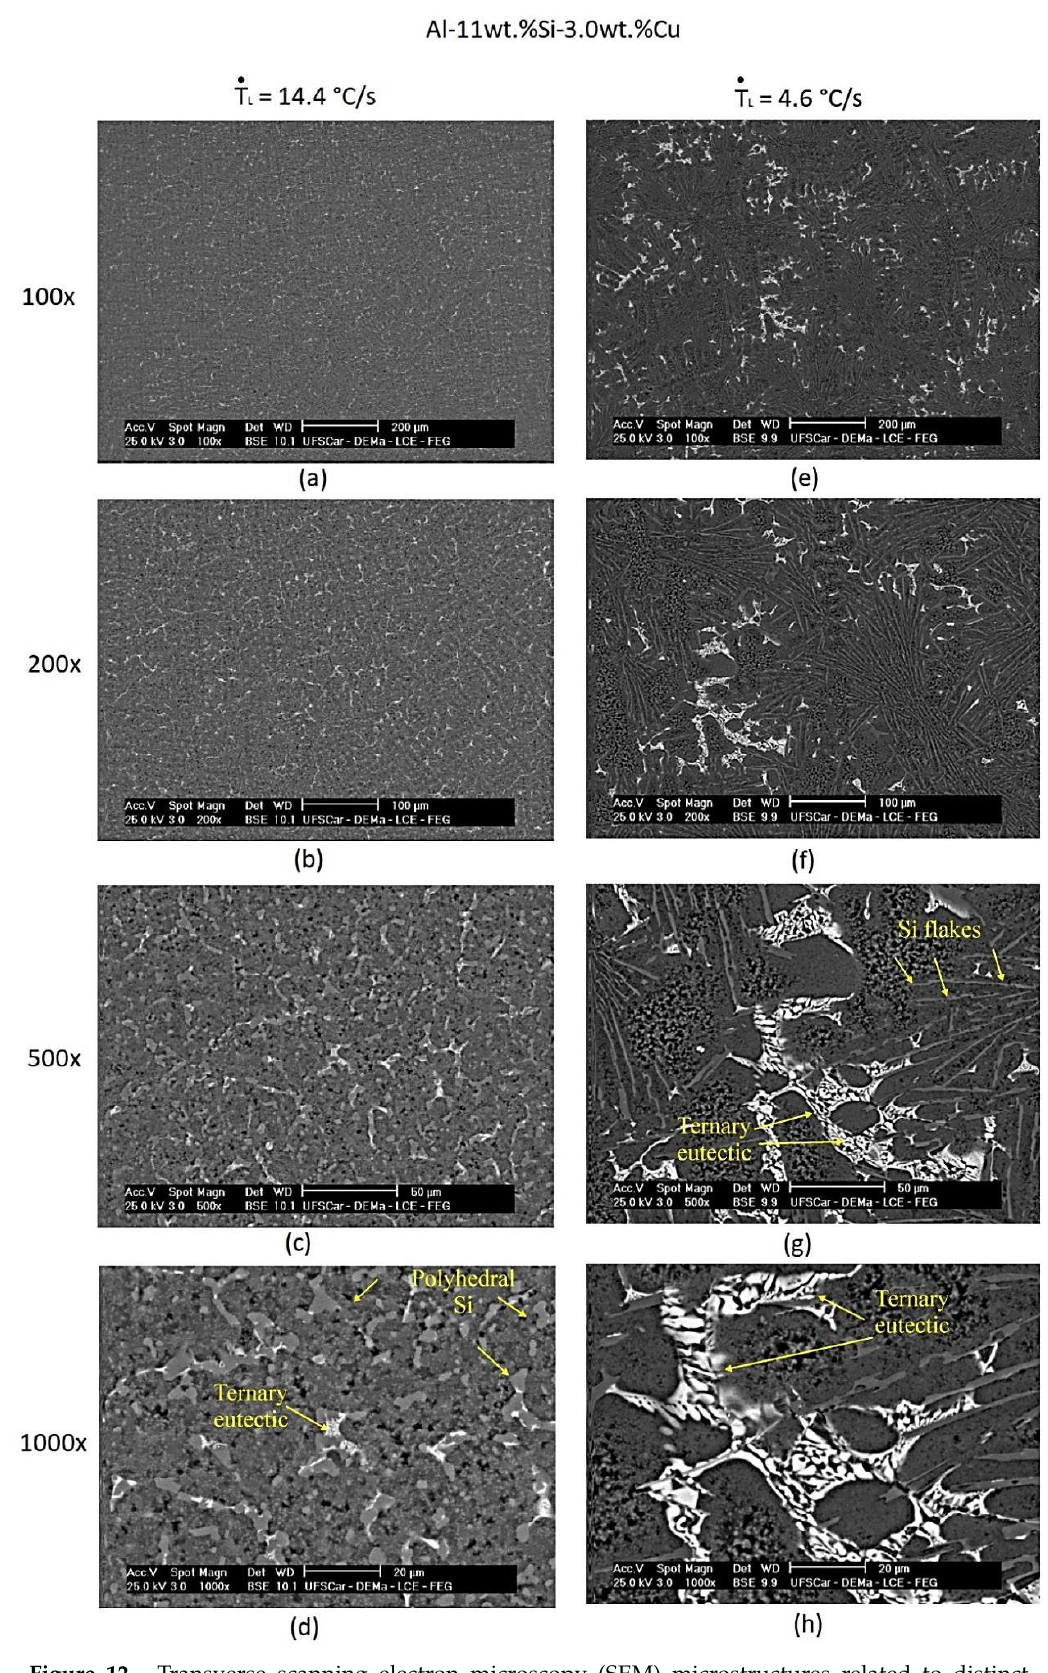
Figure 12. Transverse scanning electron microscopy (SEM) microstructures related to distinct magnifications and cooling rates (i.e., ( a – d ): 14.4 °C/s and ( e – h ): 4.6 °C/s) during directional solidification of the Al-11wt. %Si-3.0wt. %Cu alloy.